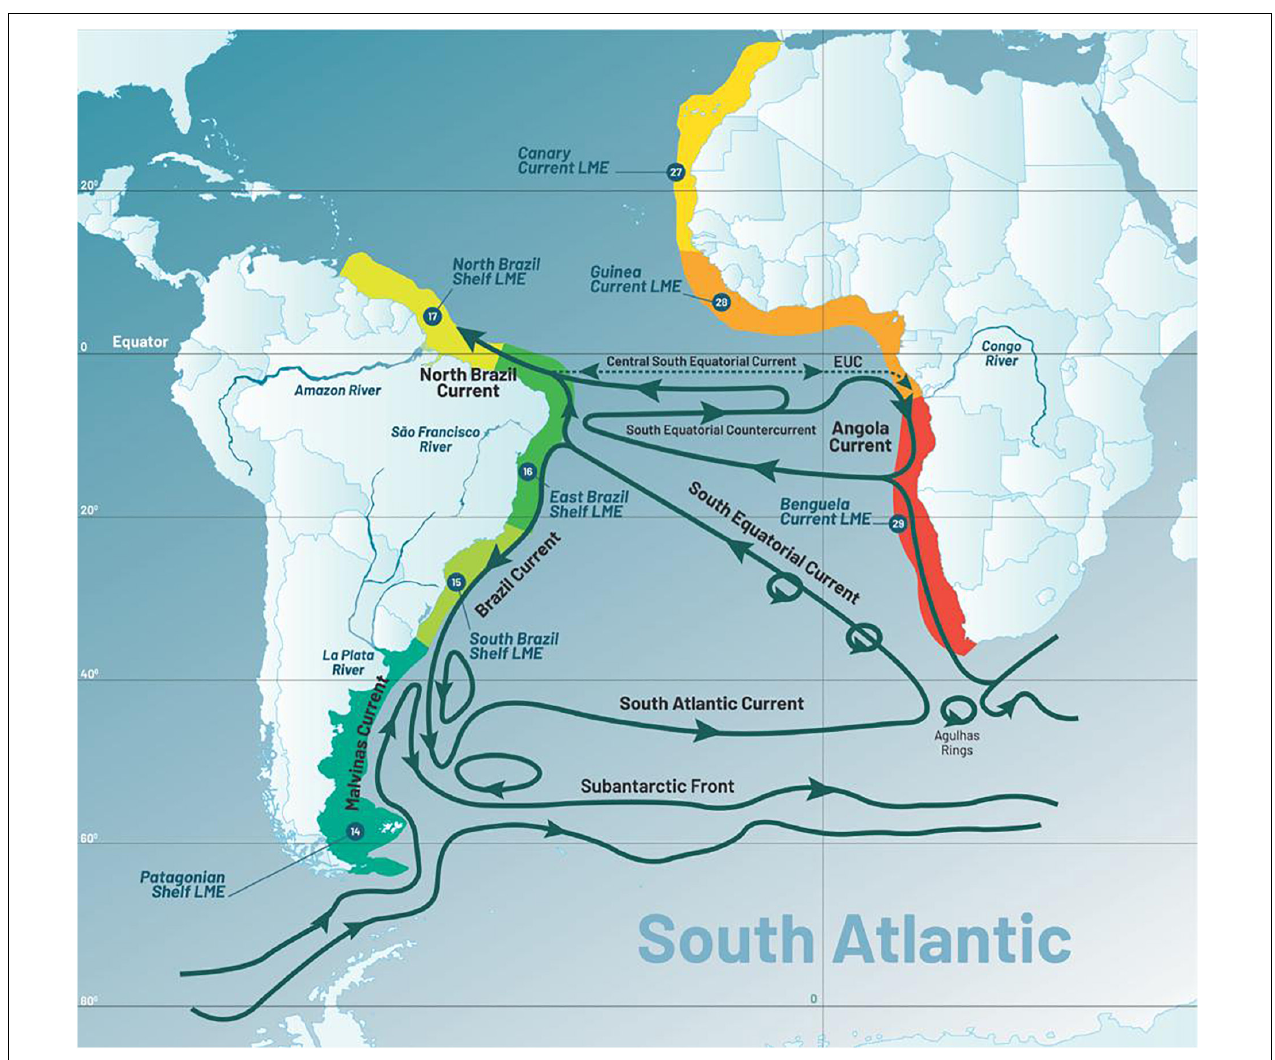
FIGURE 1 | Environmental settings of the South Atlantic Ocean, showing surface circulation schematics, large rivers, and the Large Marine Ecosystems (LMEs) present in the region. Adapted from Talley et al.